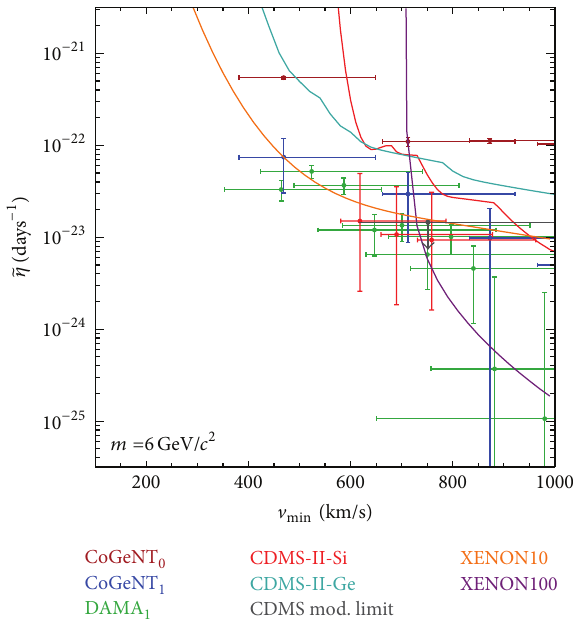
Figure 4: Measurements of and bounds on V −10 min V 10 min ̃𝜂 0 ( V min )𝑐 2 and ̃𝜂 1 ( V V −10 V 10 )𝑐 2 for MDM of mass 𝑚 = 6 GeV/ 𝑐 2 . min min min